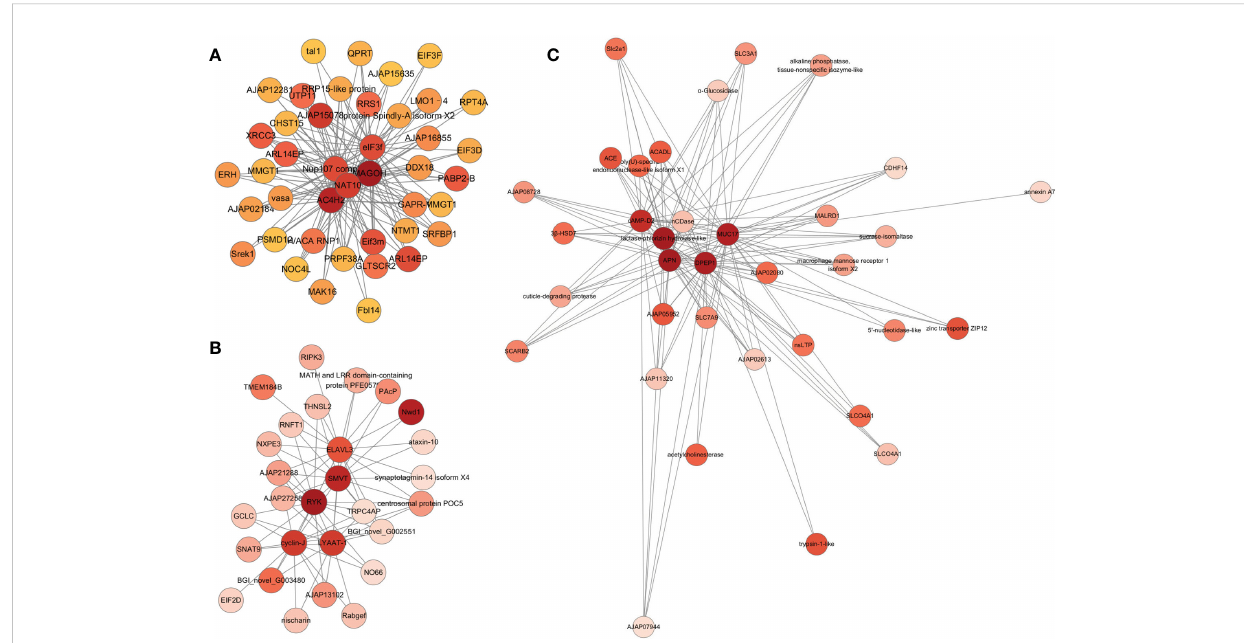
FIGURE 3 Correlation network visualization of the interactions between the top 5 genes with the highest connectivity in three target modules. Each node labelled with the abbreviation of gene name. Node colors represent connectivity, and darker nodes represent higher connectivity. (A – C) represent blue, darkslateblue and yellow module,